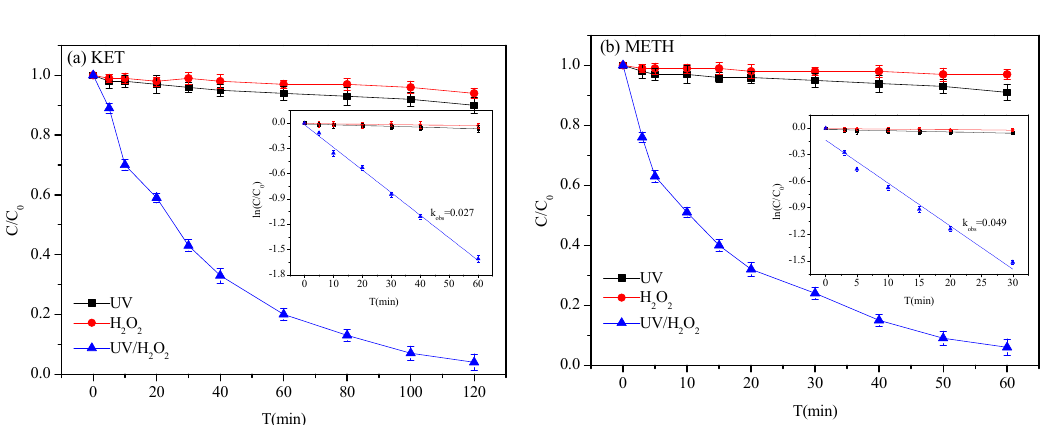
Figure 2. Degradation kinetics of ketamine (KET) ( a ) and methamphetamine (METH) ( b ) by different treatments. Conditions: Initial concentrations of KET and METH = 100 μg/L, Initial concentration of hydrogen peroxide (H 2 O 2 ) 0 = 500 μM, pH 0 = 7.0, Temperature (T) = 25 ± 1 °C. OH2HOOH hv---